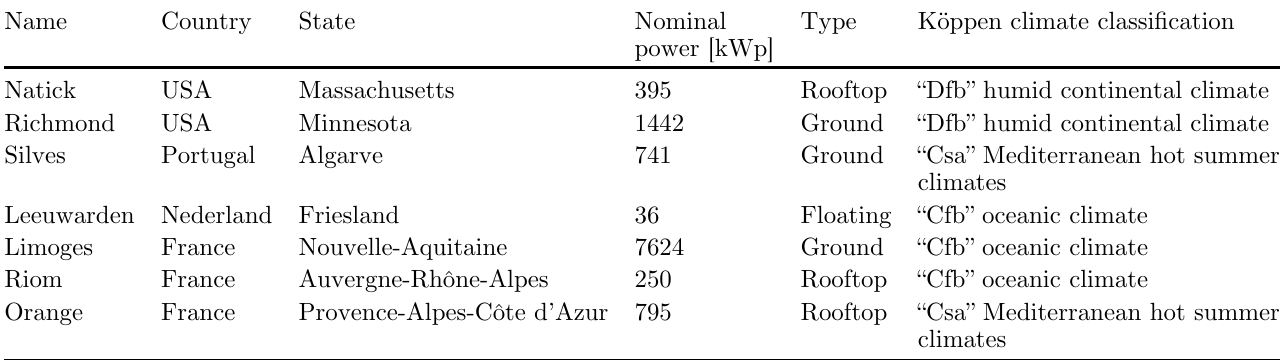
Table 1. Characteristics of the PV plants.